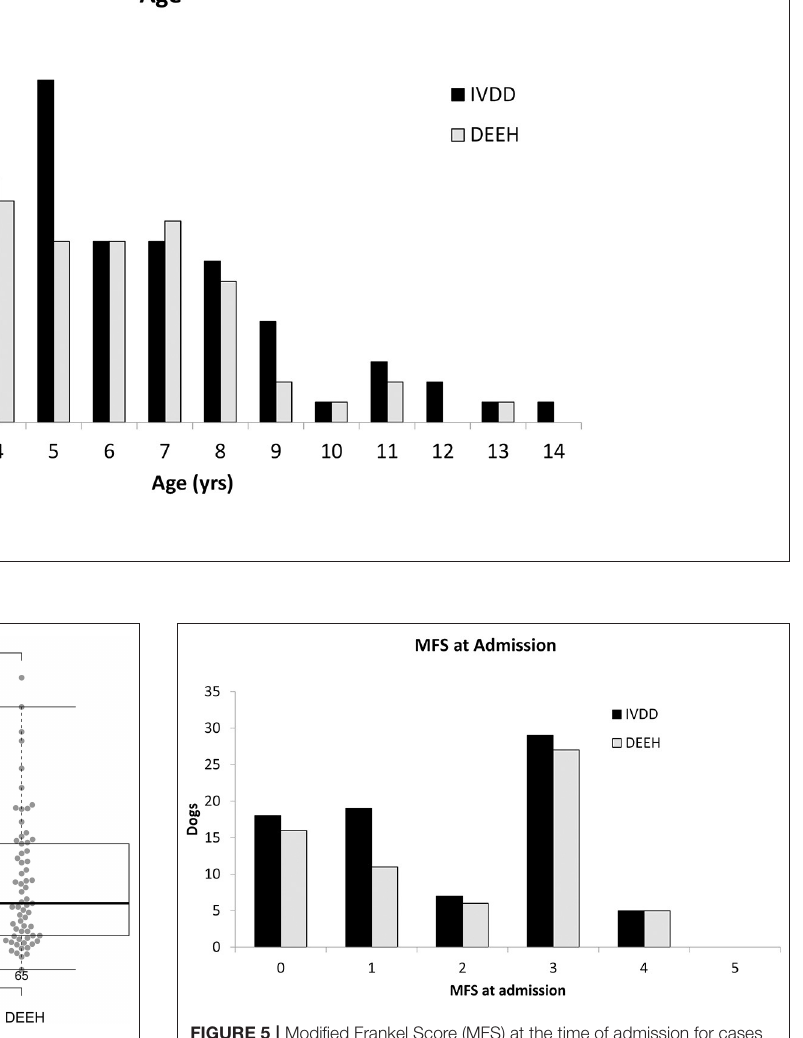
FIGURE 4 | Body weights (kg) for IVDE control group and DEEH compression group.